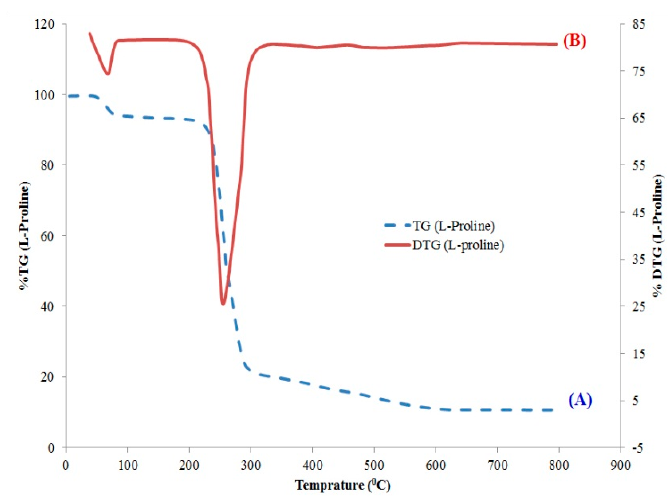
Figure 2. TGA ( A ) and DTG ( B ) curves of pristine L -proline.